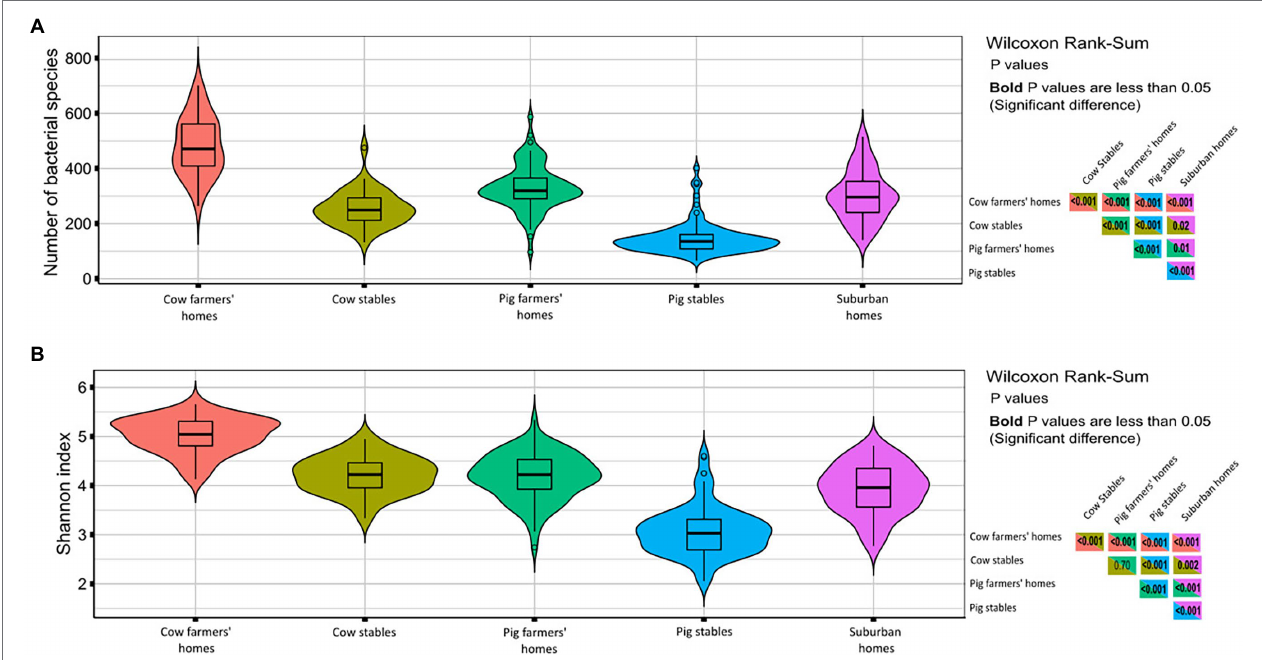
FIGURE 2 | Diversity measures in different indoor environment. The right-hand panels show p values from Wilcoxon rank sum test comparing richness/Shannon index in different indoor environments. p values in bold are less than 0.05 indicate significant differences. (A) Violin plots richness in term of number of bacterial species (OTUs). (B) Violin plots of Shannon index considering both the richness and